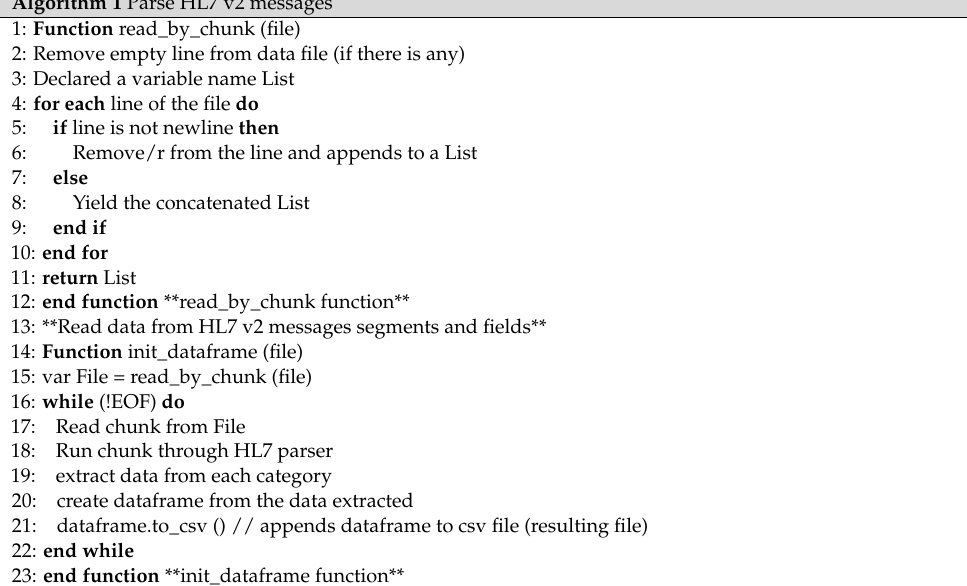
Algorithm 1 Parse HL7 v2